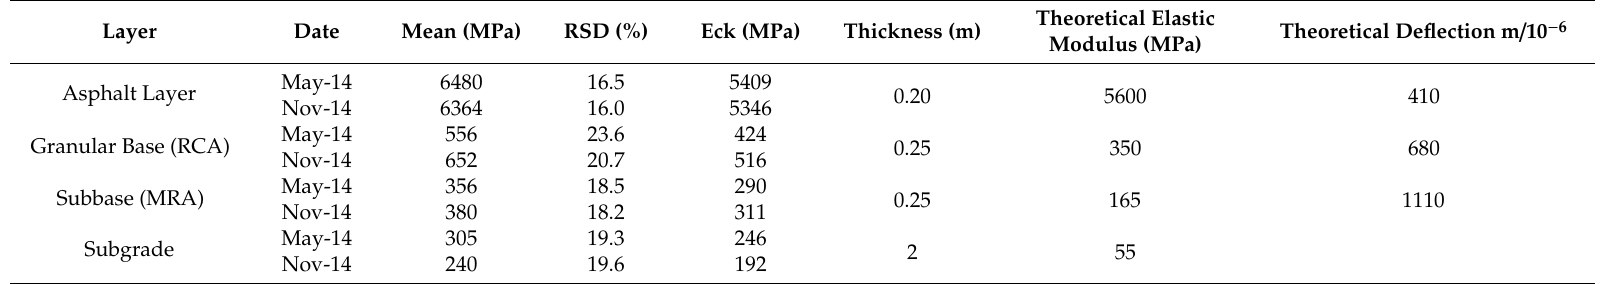
Table 9. Theoretical mechanical property and statistical parameter